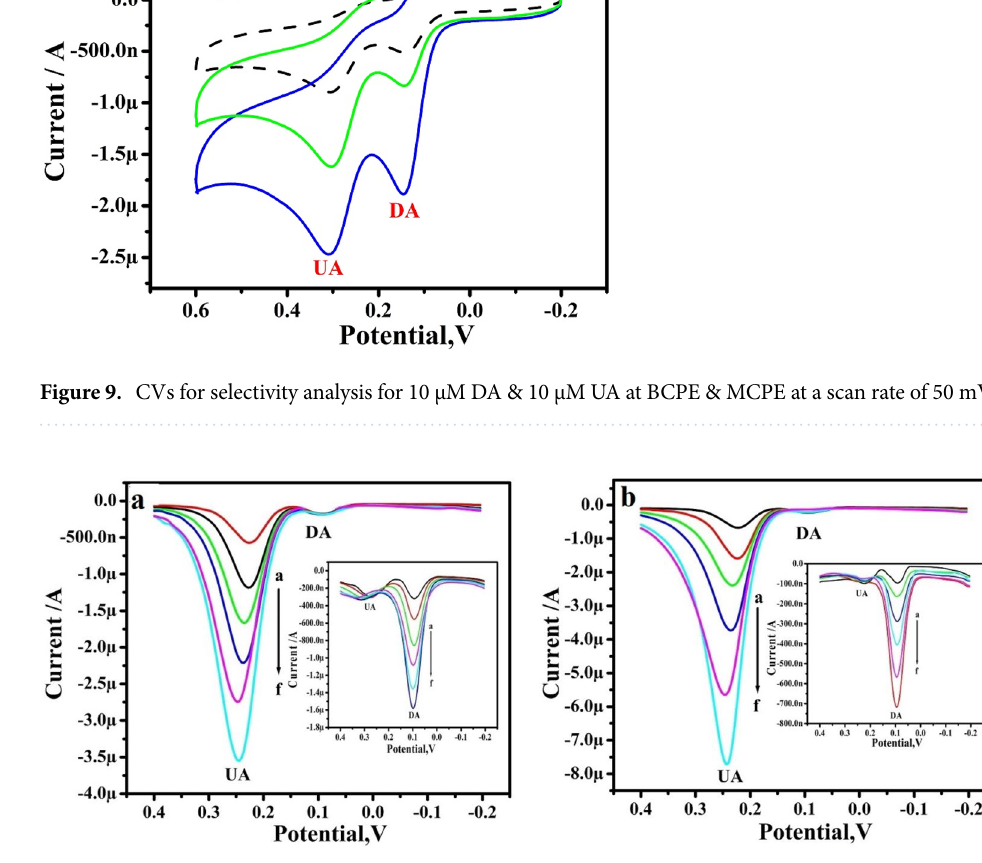
Figure 10. DPVs for different concentrations of 10–60 µM UA in PBS (pH 7.4) with 10 µM DA at ( a ) RGO-